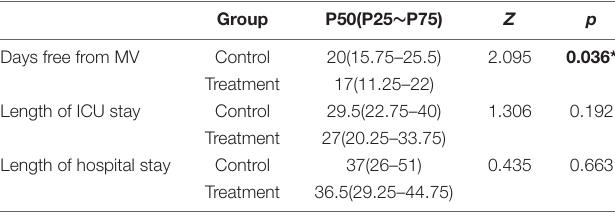
TABLE 4 | Other end points of patients in the control and treatment